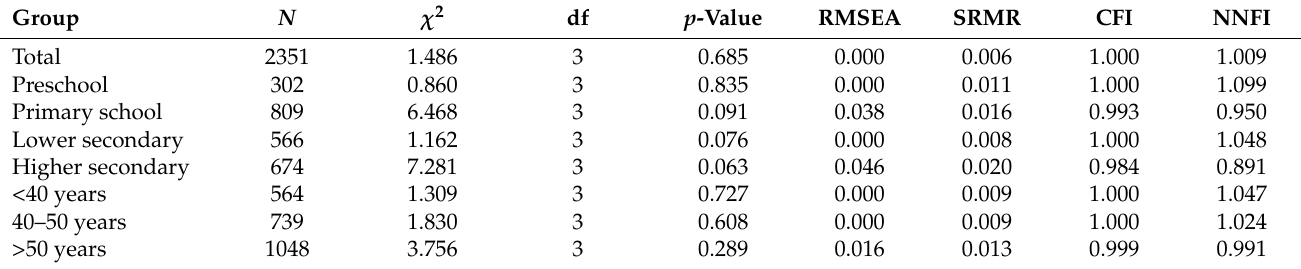
Table 5. Fit indexes of Model 2.